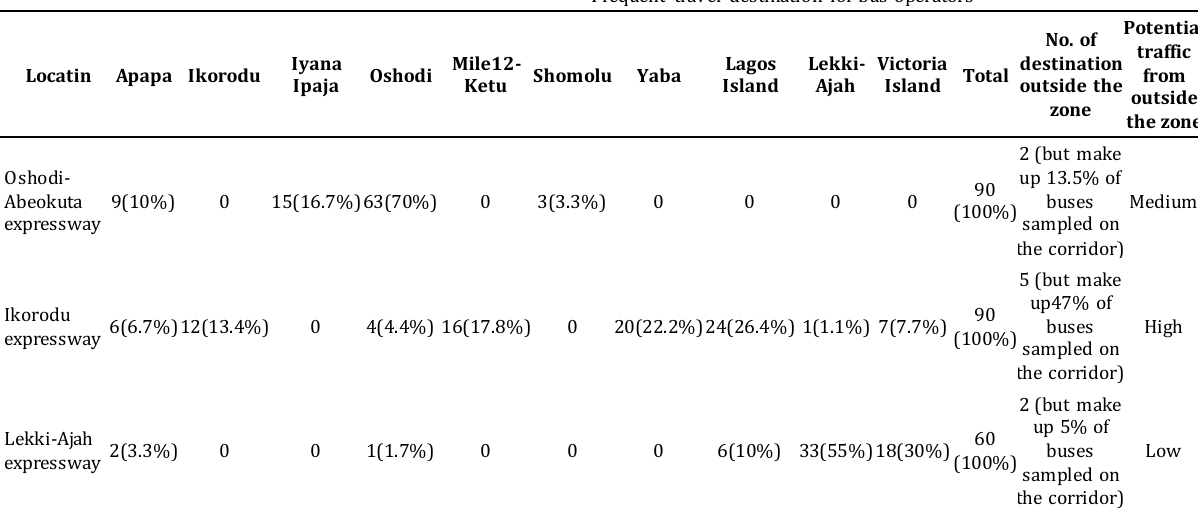
Table 3: Distribution of bus operators' most frequent destinations within the study area Frequent travel destination for bus